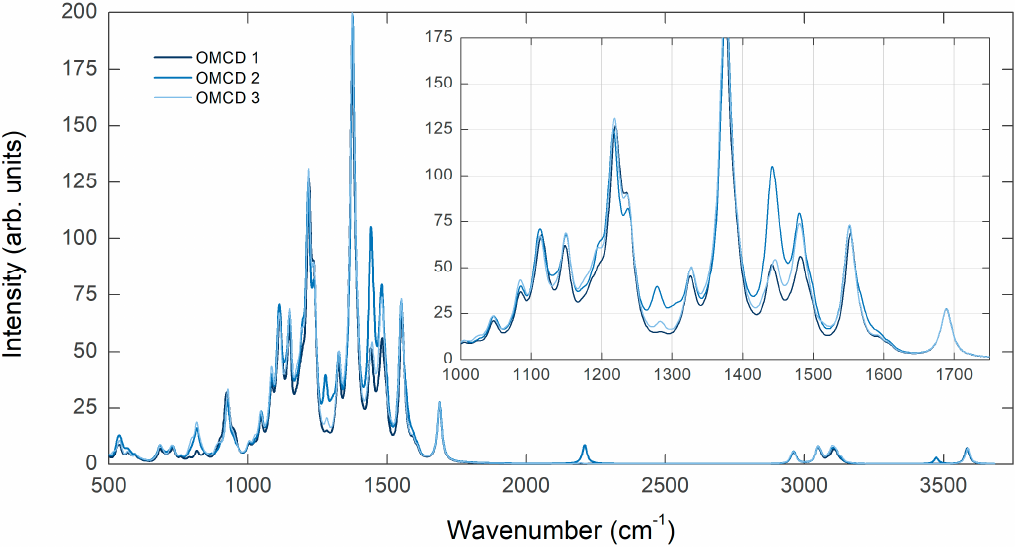
Figure 2. Vibration spectra of the three dyes, OMCD1, OMCD2, OMCD3 calculated by DFT at B3LYP / DZVP level. The spectral lines were convoluted with Lorentz distributions of 20 cm − 1 linewidth at half maximum. The inset shows a detail of the fingerprint region.